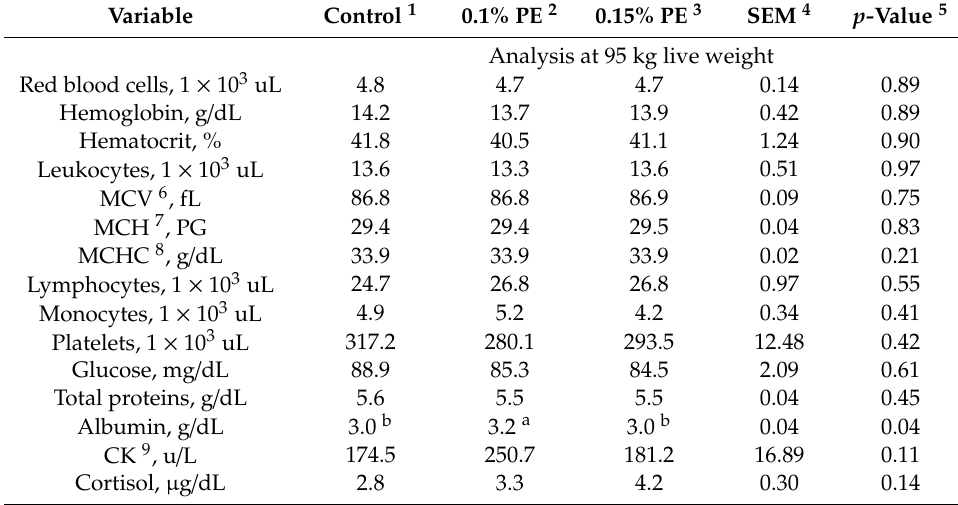
Table 3. Blood metabolites, sampled at 95 and 120 kg of average live